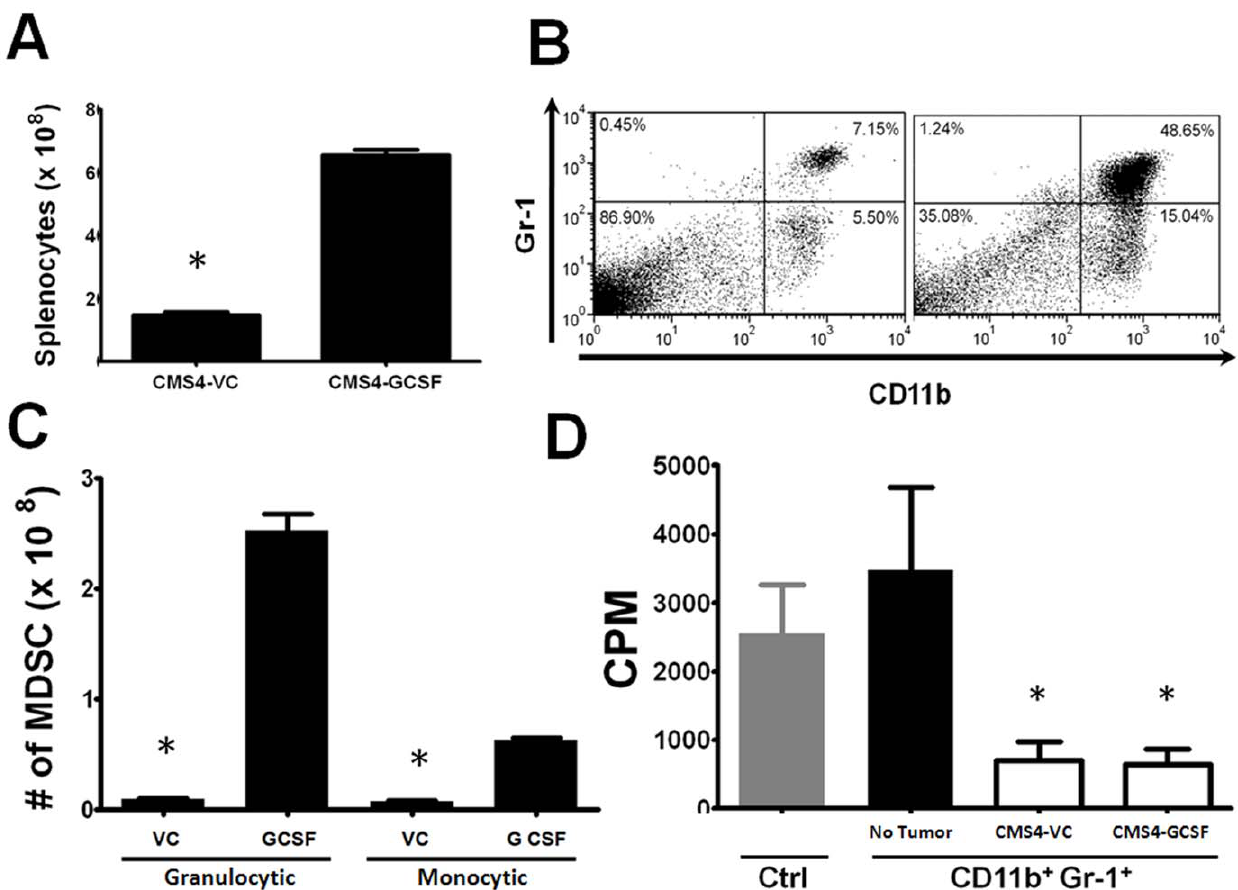
Figure 7. G-CSF over-expression enhances MDSC accumulation. ( A ) Splenocyte numbers were quantified from BALB/c mice with equivalent tumor burdens ( , 1000 mm 3 ) of vector control and G-CSF-producing CMS4 cells. This experiment is separate from that shown in Fig. 5. Splenocyte counts were significantly higher (* P , 0.0002) from mice bearing the G-CSF-producing tumor cells compared to the vector control (n=5 mice each). ( B ) Flow cytometric analysis of unfractionated splenocytes in panel A revealed a dramatic increase in the percentage of CD11b + Gr-1 + cells (upper right quadrant) in mice bearing the G-CSF-producing CMS4 cells compared to the vector control. ( C ) Splenocytes in panel B were evaluated for granulocytic and monocytic MDSC subsets based on additional staining with Ly6G and Ly6C mAb. Absolute numbers of the MDSC subsets were then calculated using splenocyte data in panel A . G-CSF over-expression resulted in a significant increase (* P , 0.0001) in both subsets, although a more pronounced effect in terms of numbers was seen in the granulocytic subset (n=3 mice each). ( D ) CD11b + Gr-1 + cells isolated from mice in panel A were assayed for their ability to suppress T cell proliferation in a one-way MLR (1 of 2 experiments) (* P , 0.02 compared to the control).